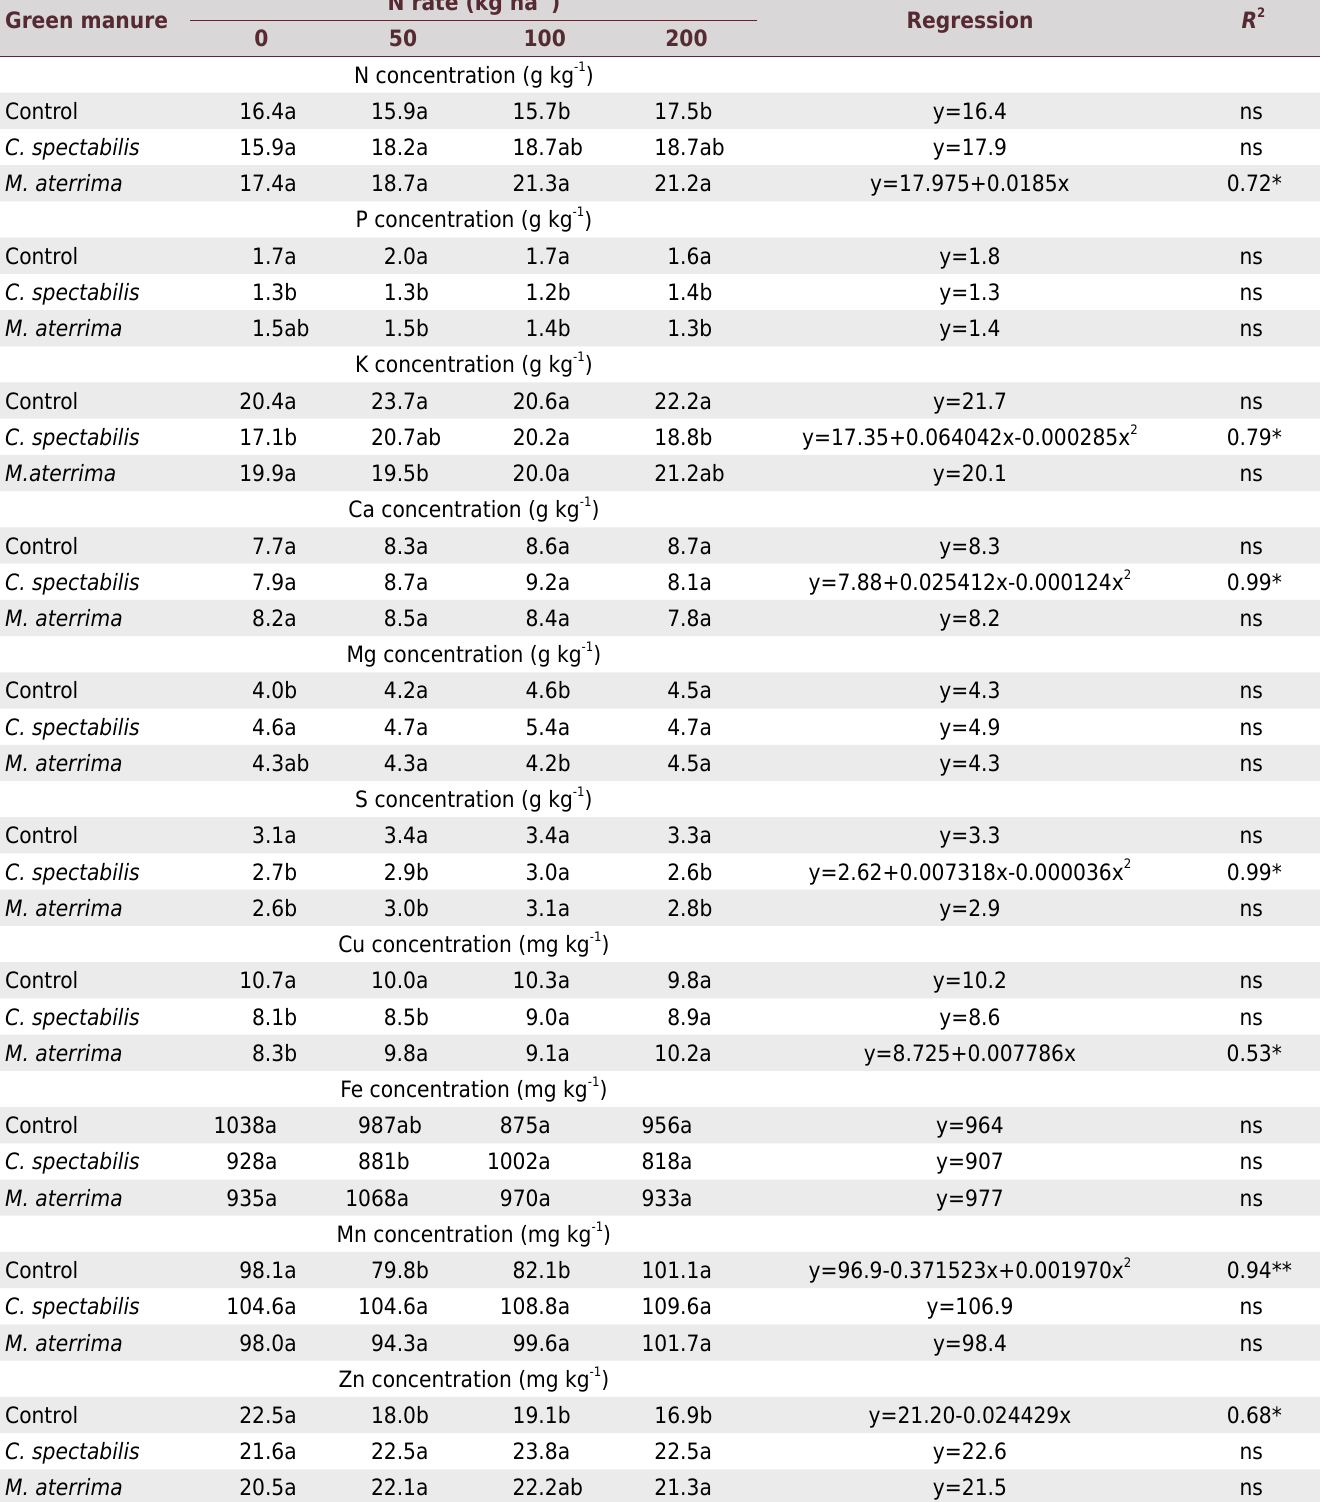
Table 5. Green manure × N rate interaction for nutrient concentration in the shoot of sweet potato. Data are the means of the two agricultural years Green manure